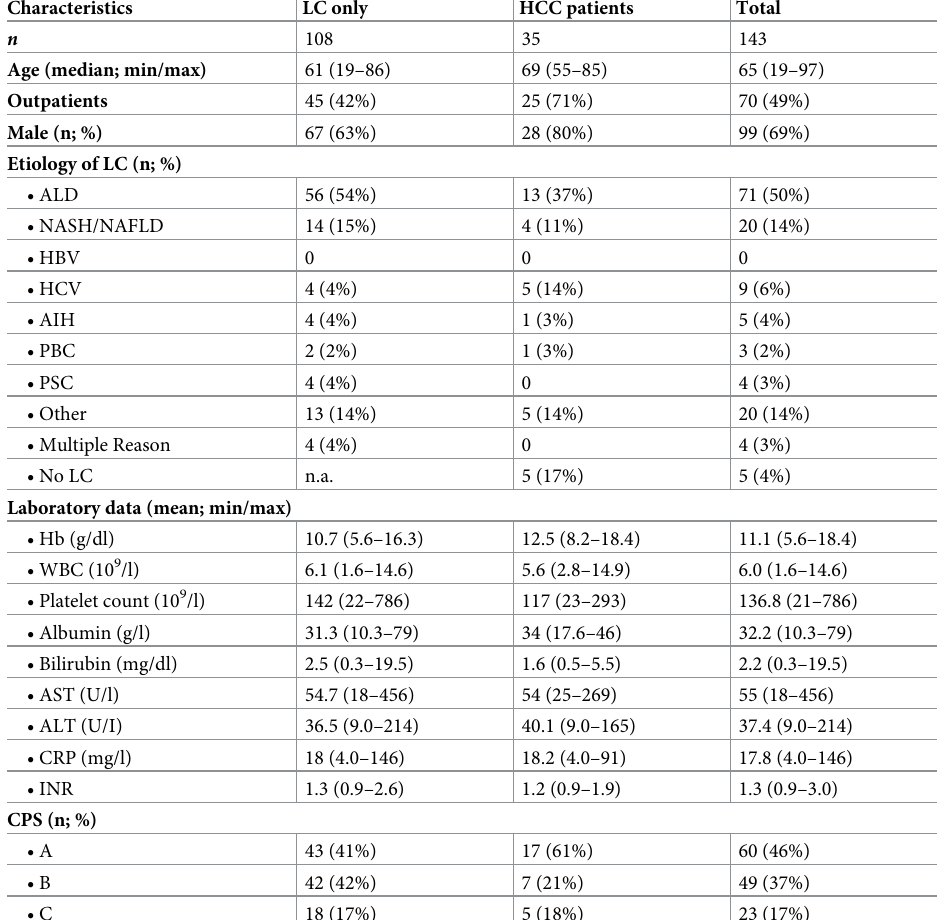
Table 2. Clinical characteristics and laboratory findings at baseline of patients with liver cirrhosis (LC) and/or hepatocellular carcinoma (HCC). Characteristics